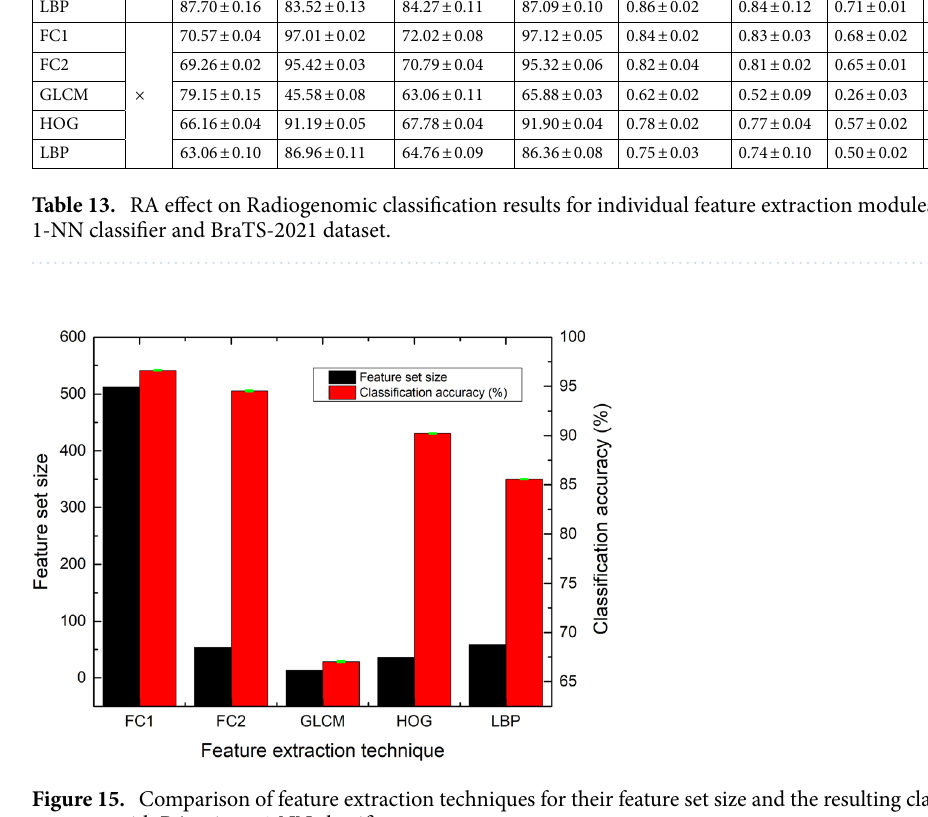
Figure 15. Comparison of feature extraction techniques for their feature set size and the resulting classification accuracy with RA using a 1 -NN classifier.